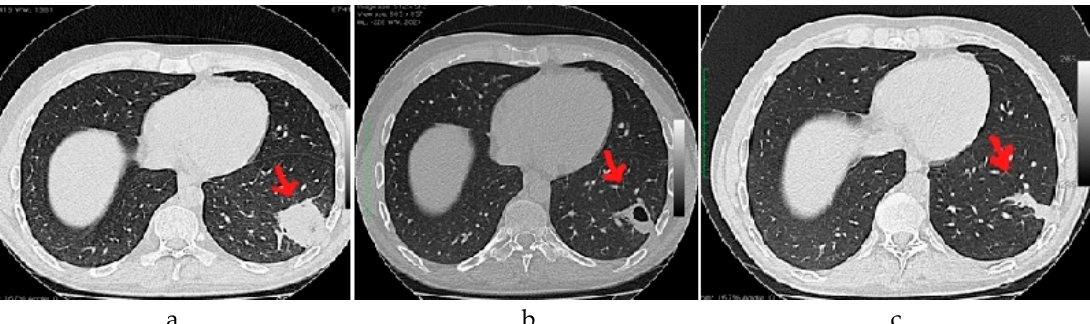
Figure 1. Chest CT scan demonstrating the evolution of an infiltrate in the inferior lobe of left lung due to septic pulmonary embolism by S. aureus infection (see Table 3, patient C). ( a ) At the diagnosis; ( b ) After 15 days antibiotic therapy; ( c ) Follow up one month after the end of antibiotic therapy.